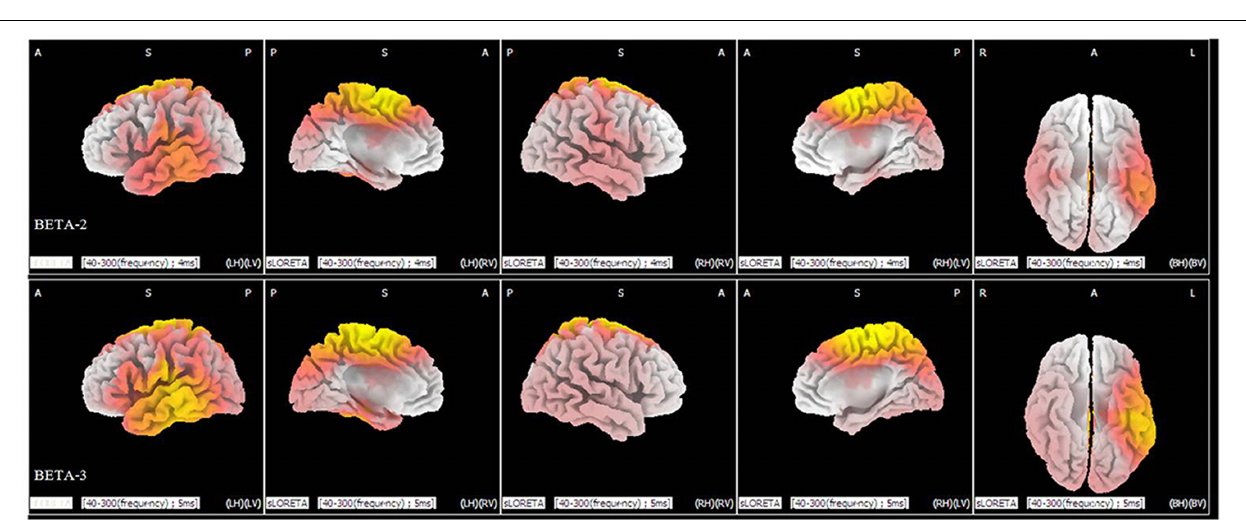
FIGURE 3 | The grand-averaged ERPs of the N400. The grand-averaged ERPs waveforms of the N400 under the conditions of incongruence (blue solid), congruence (green dashed), and control (red) at the Cz and CPz electrode sites.